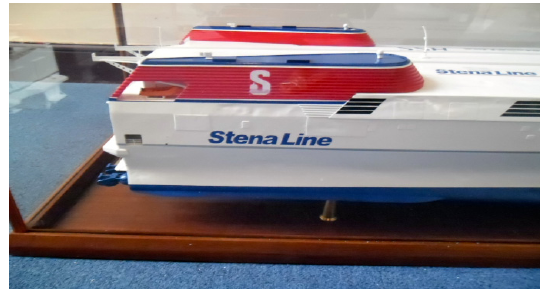
Figure 2. Ferry Terminal fragment, 2015. © Silvia Loeffler, Glas Journal, 2015.